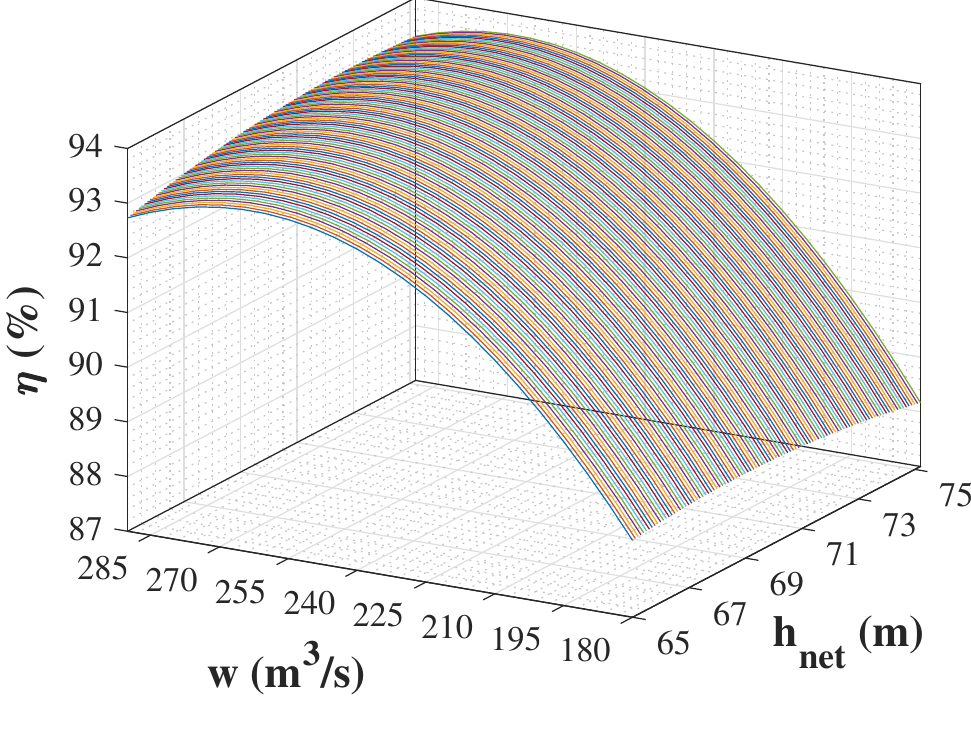
Figure 1. G 2 ’s turbines efficiency